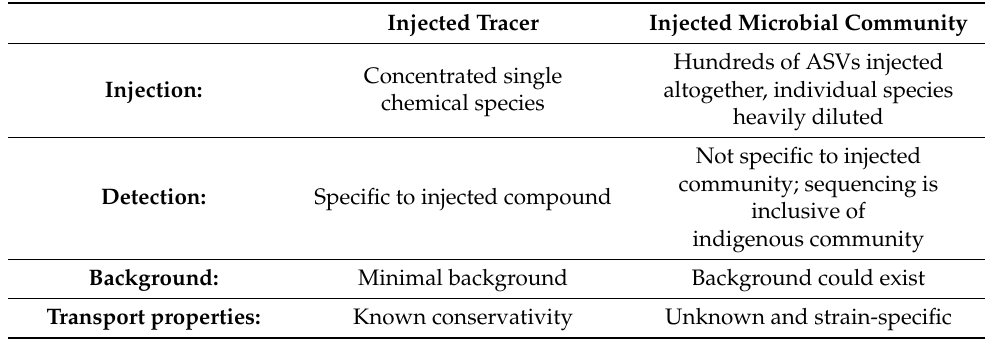
Table 2. Comparison of injected tracer and injected microbial community in this